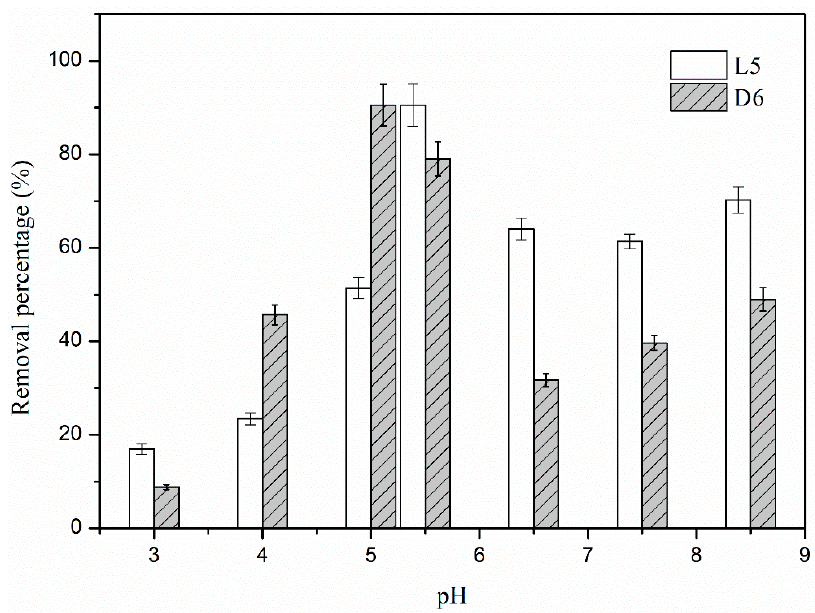
Figure 5. Effect of pH on the adsorption of L5 and D6 on MSW (conditions: V = 50 mL; L5 and D6 concentrations = 20 ppb; MSW dosage = 10 g; T = 298 K).